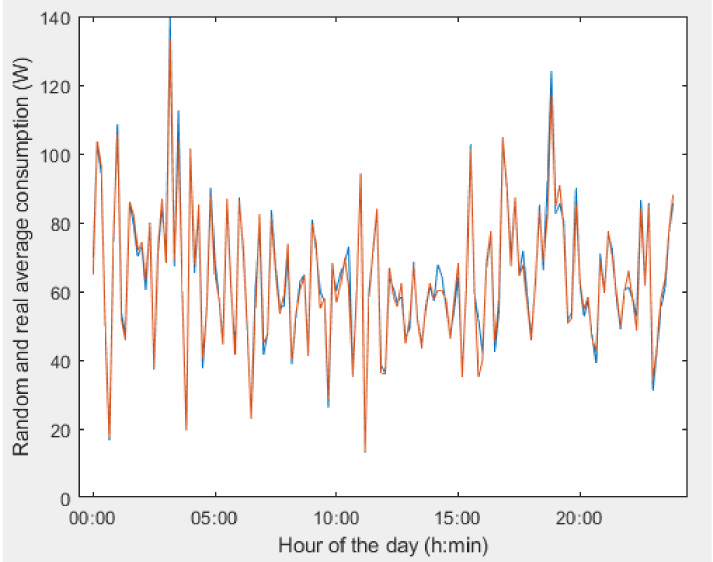
Figure 8. Random (blue) and real (orange) average consumption of the refrigerator during Saturdays.